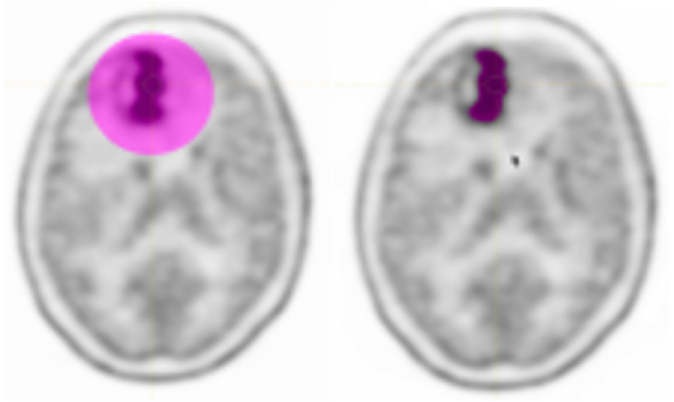
Figure 2. Initial user input and result of segmentation (Example patient).